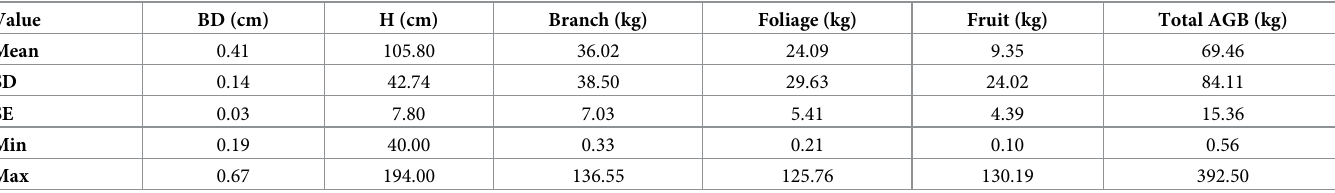
Table 2. Statistical characteristics and biomass of N . sibirica Pall.